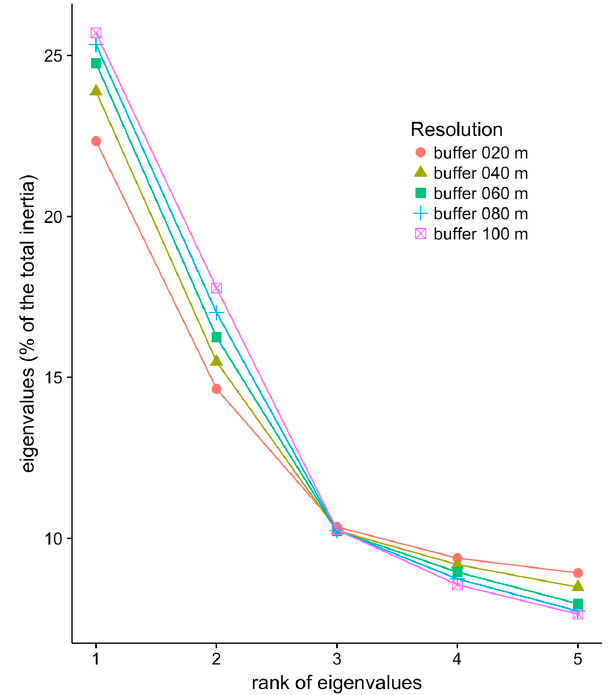
Figure 2. First five eigenvalues of the principal component analysis (PCA) of the landscape metrics computed in Niamey for different buffer sizes, i.e. at different spatial resolutions. Eigenvalues are expressed as a proportion (%) of the total inertia of the